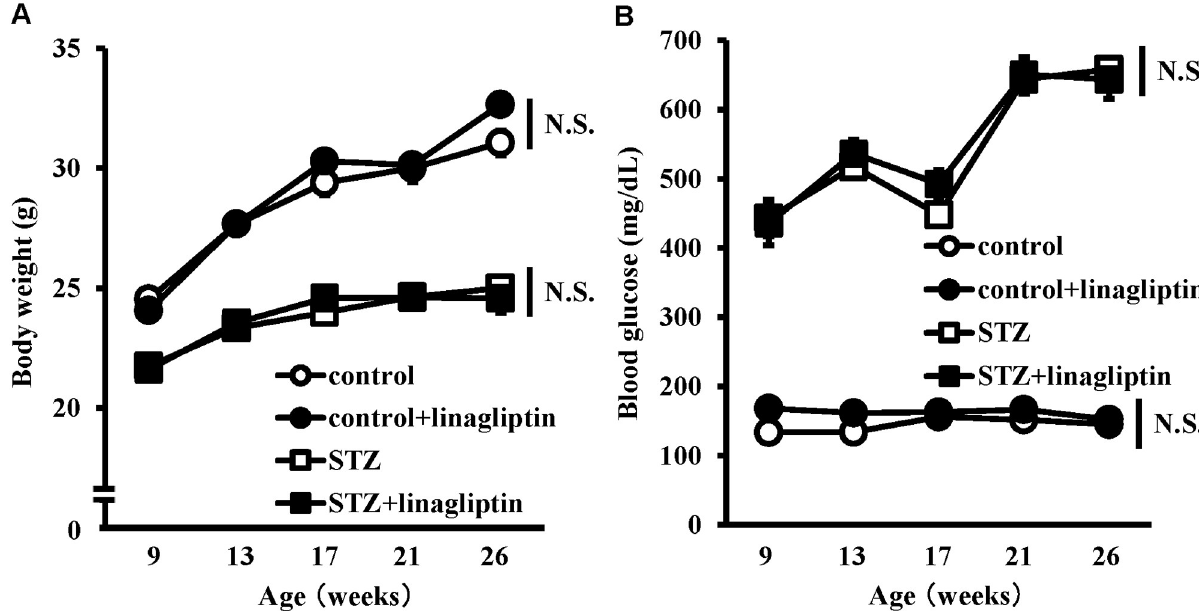
Fig 1. Body weight and blood glucose. Changes in body weight (A) and blood glucose (B) between 9 and 26 weeks of age in control mice (white circles), linagliptin-treated control mice (black circles), diabetic mice (white boxes) and linagliptin-treated diabetic mice (black boxes). Results are expressed as the mean ± SEM (n = 8); N.S., not